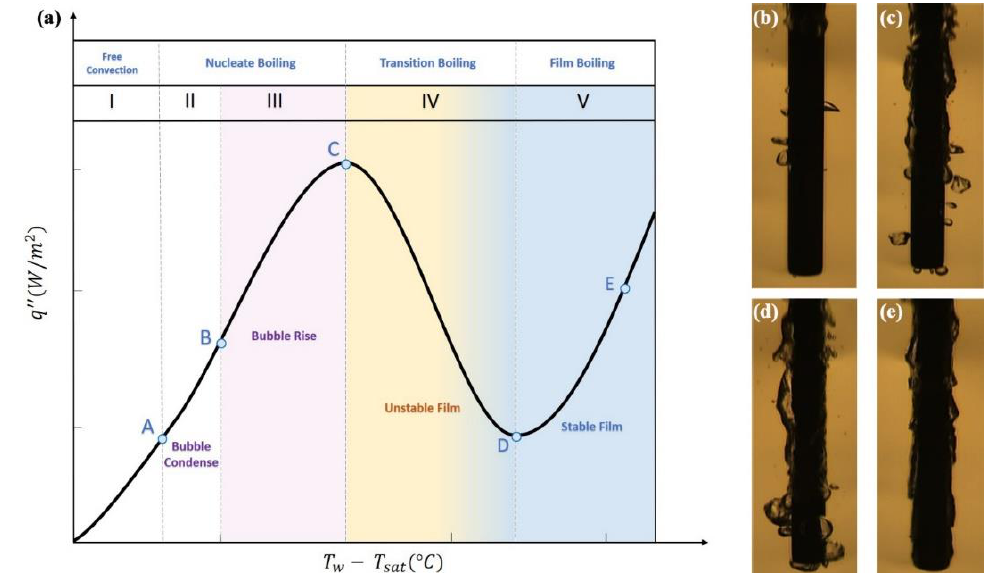
Figure 21. Boiling curve for stagnant water at atmospheric pressure (1 atm), where ( a ) shows the boiling curve and ( b – e ) illustrates the bubble formation within the free convection, nucleate boiling, transition boiling, and film boiling regimes.